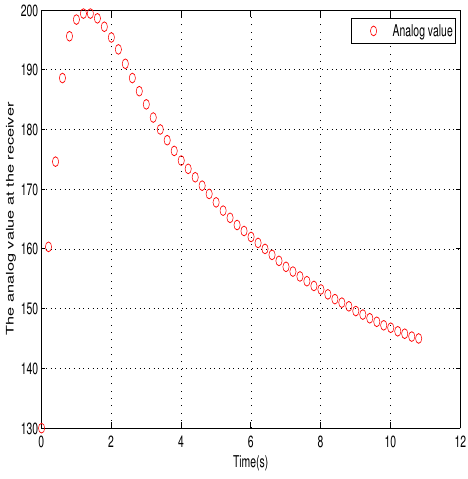
Figure 4: The analogy value at the receiver vs